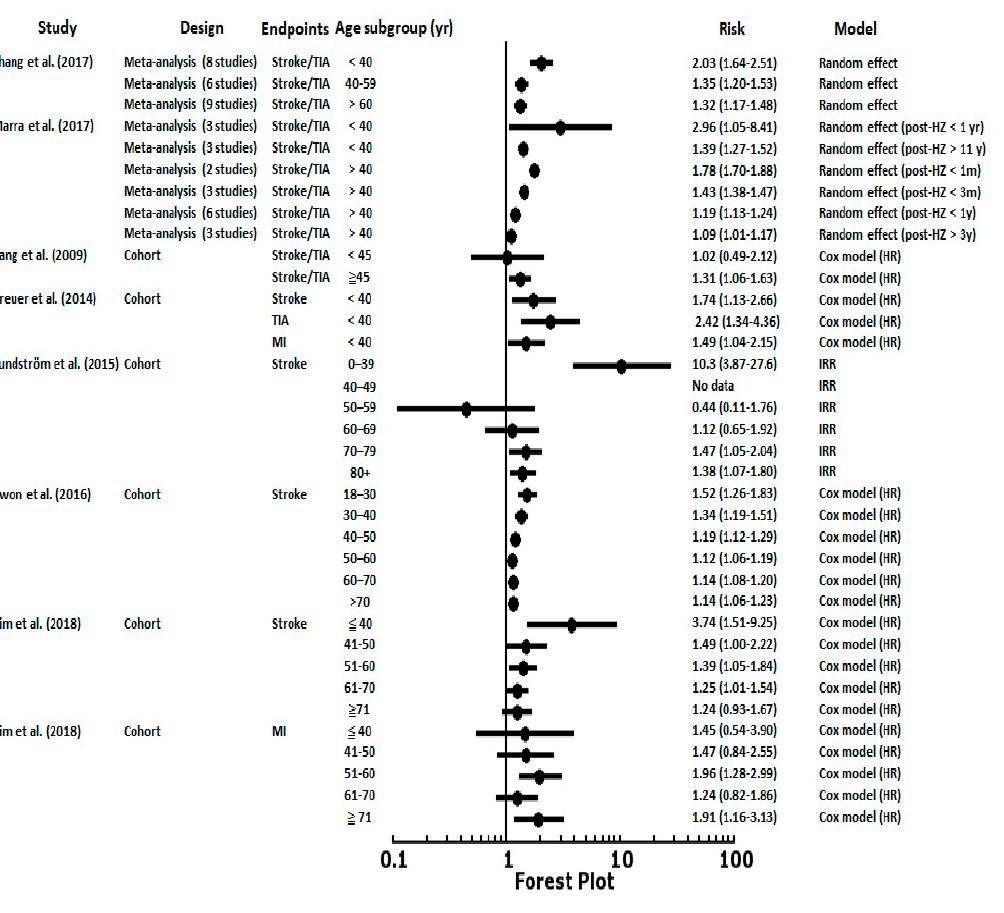
Figure 2. The results of meta-analyses and enrolled cohorts examining the risk of stroke or myocardial infarction after herpes zoster episodes in di ff erent age ranges. TIA, transient ischemic attack; MI, myocardial infarction; HR, hazard ratio; IRR, incident rate ratio.